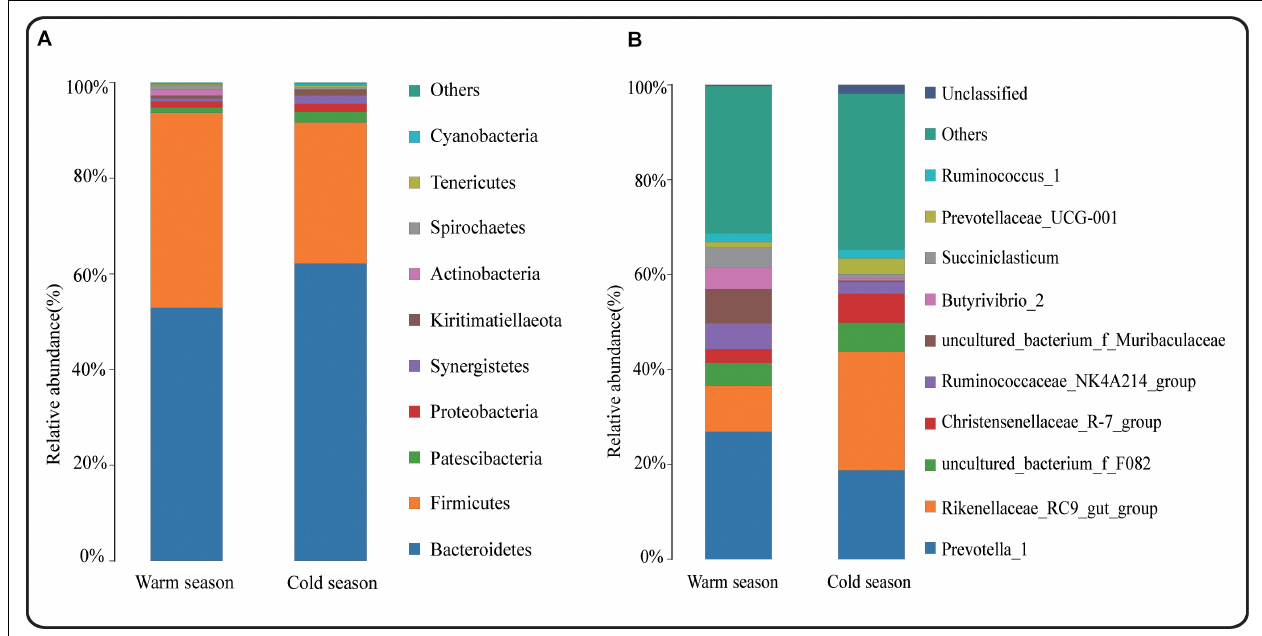
FIGURE 2 | (A) Relative abundance of phylum horizontal species; (B) Relative abundance of genus horizontal species.